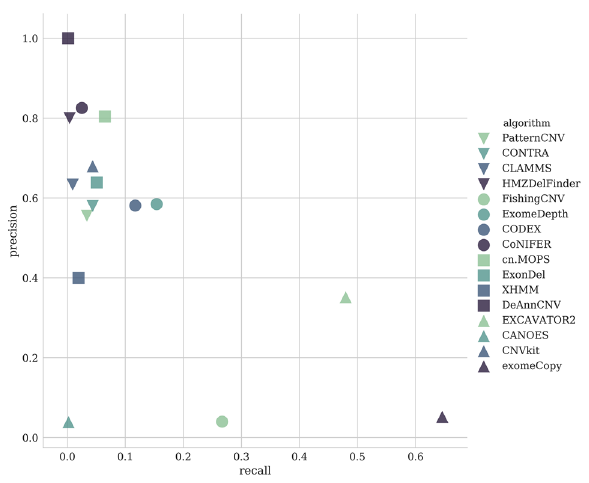
Figure 5. Recall and precision of algorithms for CNV identification using whole-exome sequencing data.The order of the algorithms is determined by the length of predicted CNVs: from small to